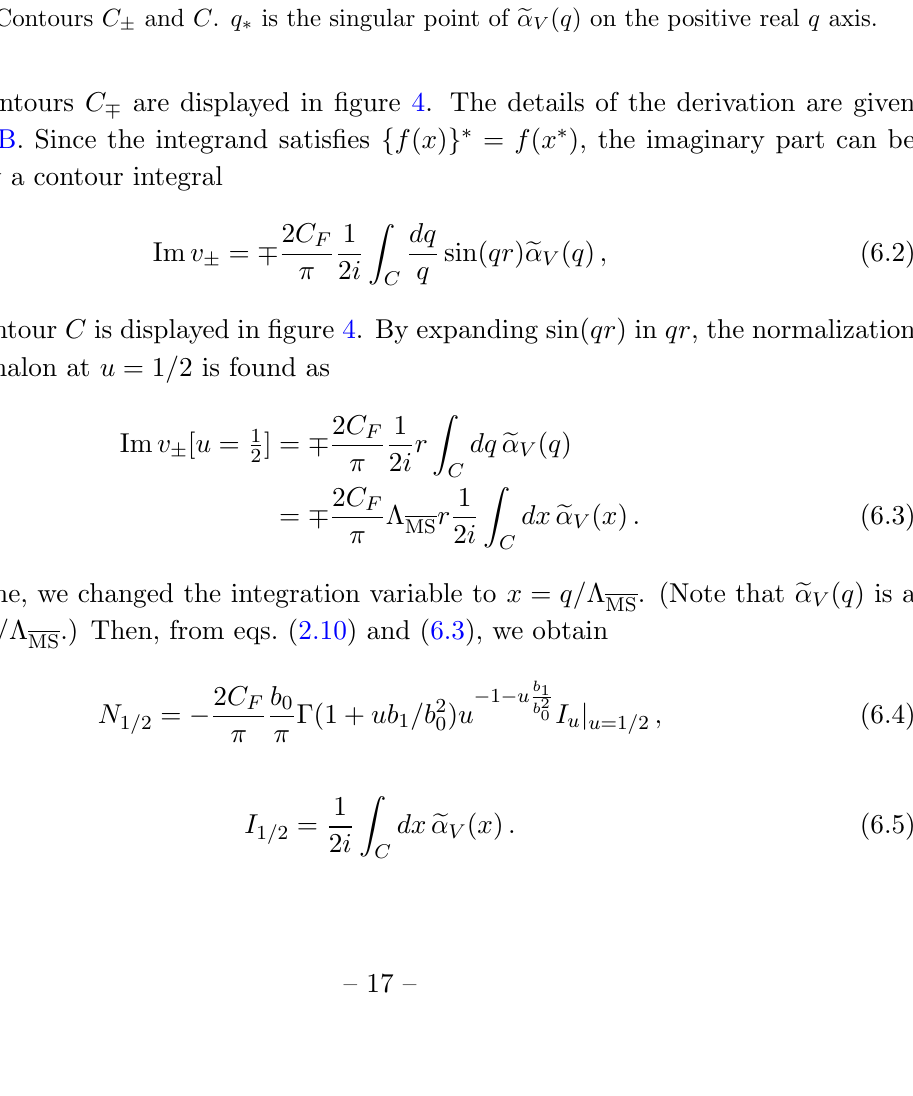
(cid:11) V ( q ) on the positive real q axis. e